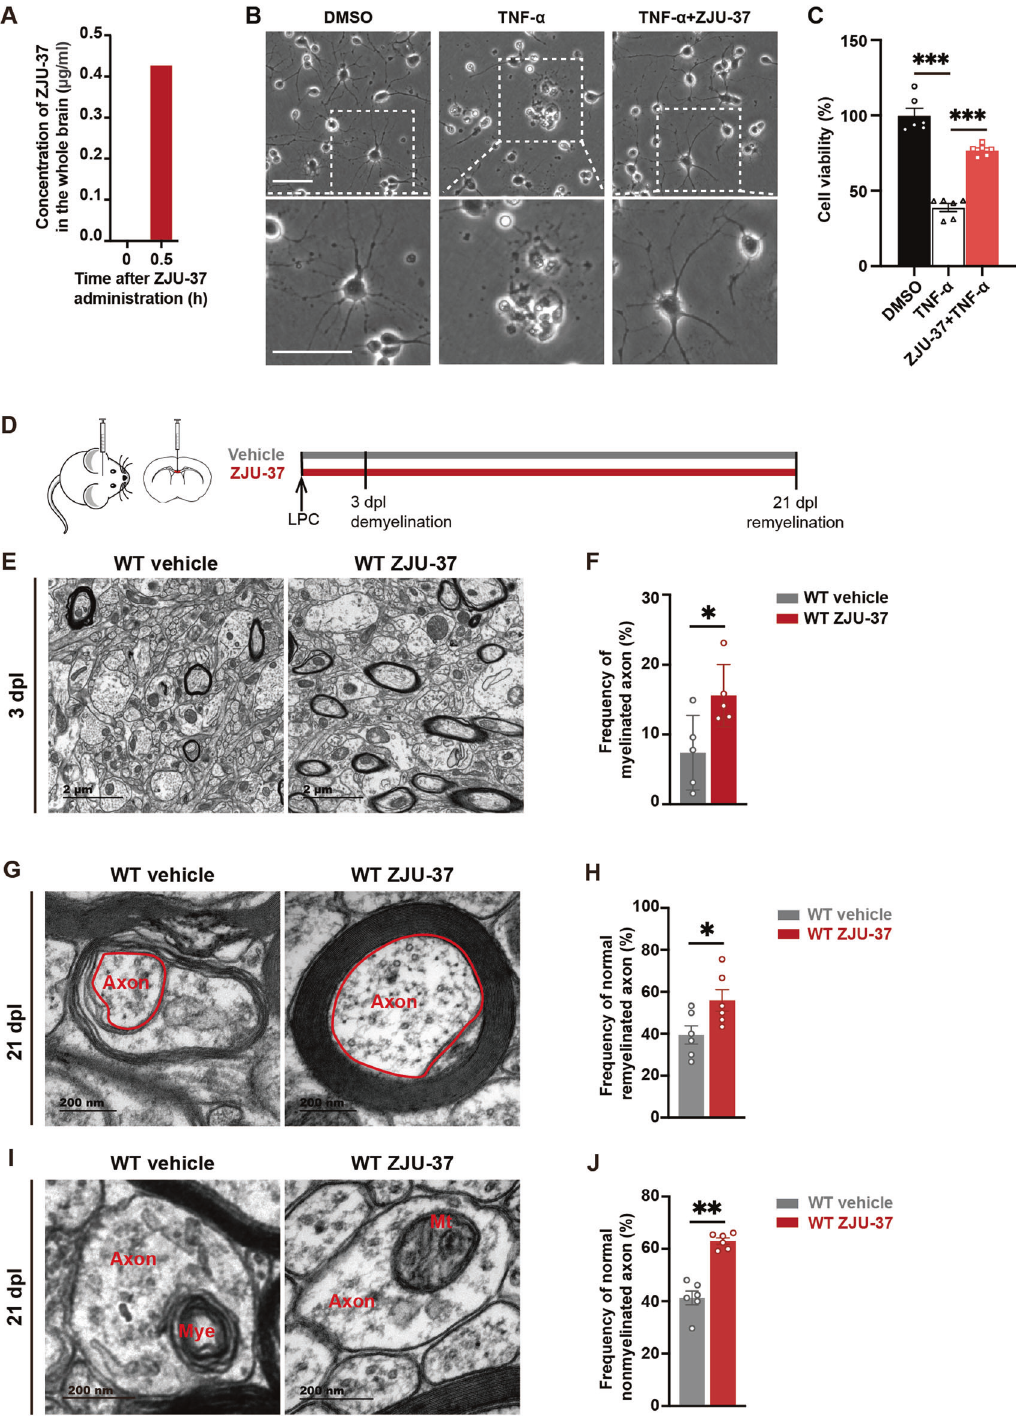
Fig. 2 ZJU-37 exhibits dual protective effects in vivo. A ZJU-37 was measured in the supernatant of the whole brain by HPLC 30 min after intraperitoneal injection of ZJU-37 (4 mg/kg). B Representative images of rat OPCs treated with mouse TNF- α (100 ng/ml) ± ZJU-37 (5 μ M) for 36 h. Scale bar: 50 μ m. C Quanti fi cation of cell viability in TNF- α ± ZJU-37 treated OPCs (one-way ANOVA, Tukey ’ s post hoc test, n = 6 plate wells for each group). D Experimental design to evaluate demyelination and the ultrastructure of axons in the demyelination lesion. E Representative transmission electron micrograph within the demyelinated lesion at 3 dpl. F Quanti fi cation of the myelinated axons (two- tailed t test) within the demyelination region at 3 dpl ( n = 5 mice). G Representative transmission electron micrographs of axons that were wrapped with myelin within the demyelination region at 21 dpl. H Quanti fi cation of the axons with normal ultrastructure and with myelin (two-tailed t test) within the demyelination region at 21 dpl ( n = 6 mice). Scale bars, 1 μ m. I Representative transmission electron micrographs of non-myelinated axons within the demyelination region at 21 dpl. Mye: myelin, Mt: mitochondria. J Quanti fi cation of the axons with normal ultrastructure but without myelin (two-tailed t test) within the demyelination region at 21 dpl ( n = 6 mice). All data are presented as mean ± SEM. * P < 0.05, ** P < 0.01, *** P < 0.001, n.s. no signi fi